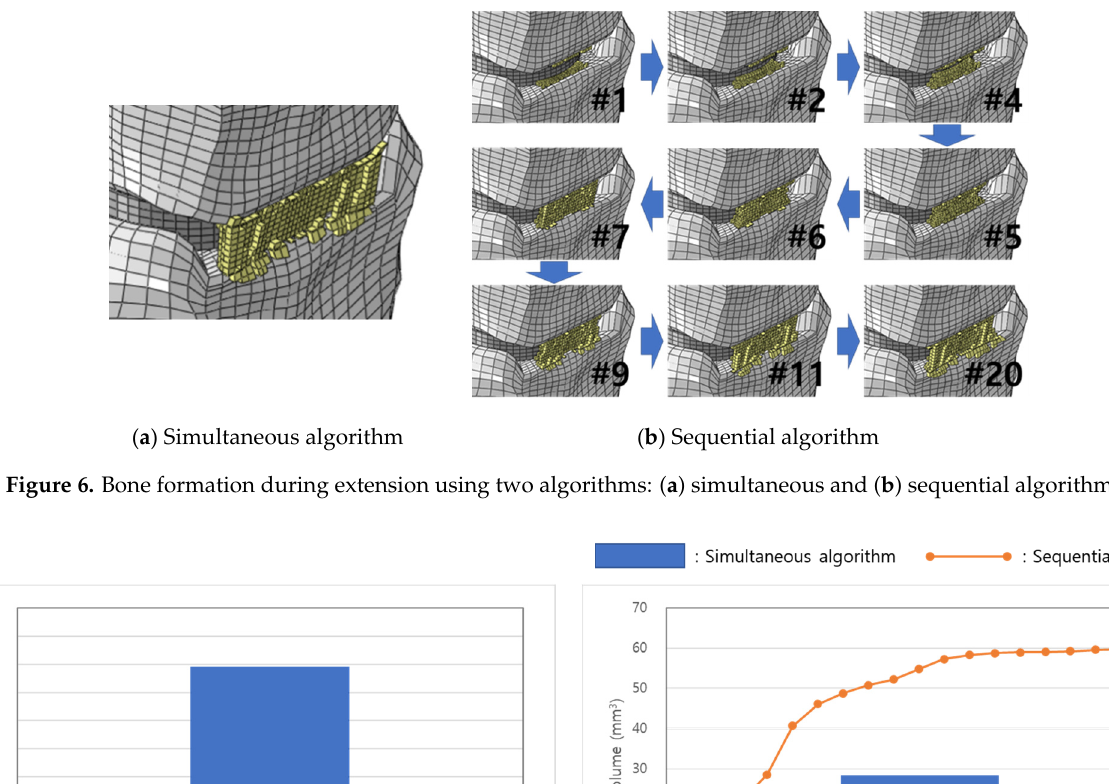
Figure 5. Bone formation during flexion using the two algorithms.